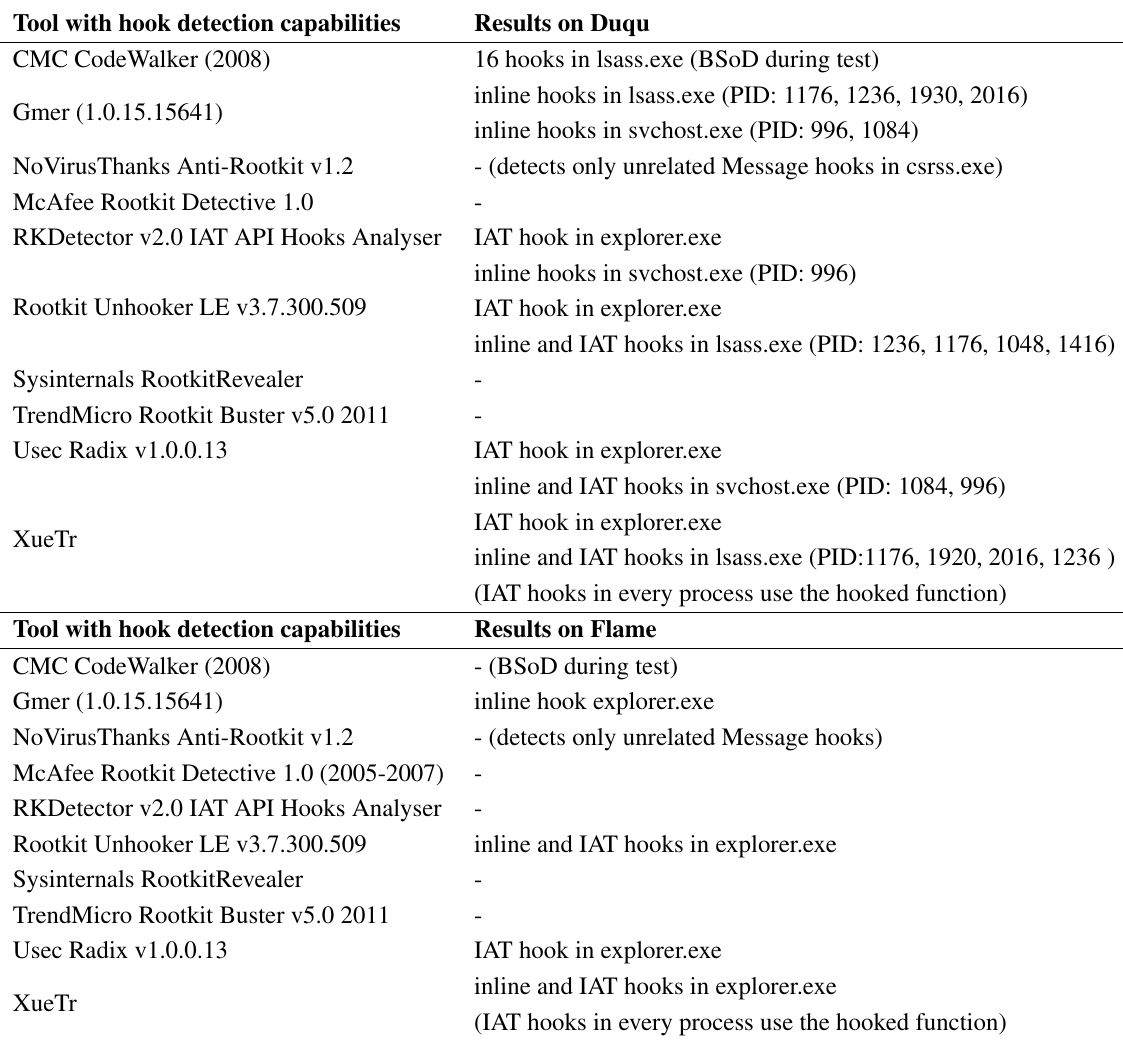
Table 9. Usermode hook detection by free anti-rootkit